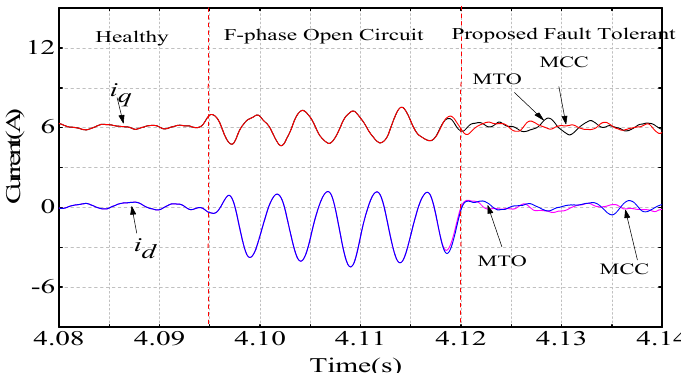
Figure 14. d-q current in fault and the proposed fault-tolerant control operation. Figure 14. d - q current in fault and the proposed fault-tolerant control